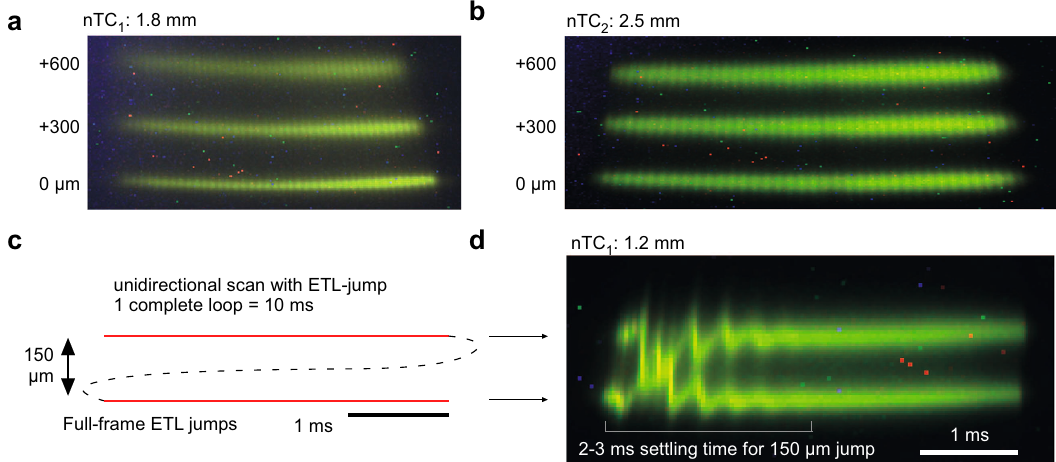
Fig. 4 Rapid remote focussing. a , b , Scan-pro fi les with the electrically tunable lens (ETL) “ fl at ” (zero input current, lowest pro fi le) and engaged to achieved axially elevated scan planes at + 300 and + 600 µ m (middle, upper pro fi les, respectively) in nTC 1 ( a ) and nTC 2 ( b ) con fi guration, as indicated. Associated size-changes in the effective full fi eld of view were generally <5% (compare top and bottom planes). In each case, axial-shifts required <25% unidirectional peak current on the ETL which in turn facilitated rapid ETL-settling times: c , d , Schematic ( c ) and measured ( d ) axial jumps and settling time: the ETL was programmed to iteratively focus up and down by 150 µ m at each end of two long (5 ms) scan lines, as indicated. This enabled a direct read-out of ETL settling at each line-onset (oscillations in d ). For the 150 µ m jumps shown, oscillations decayed below detectability within 2 – 3 ms. For corresponding readouts of the ETL-position signal, see Fig.